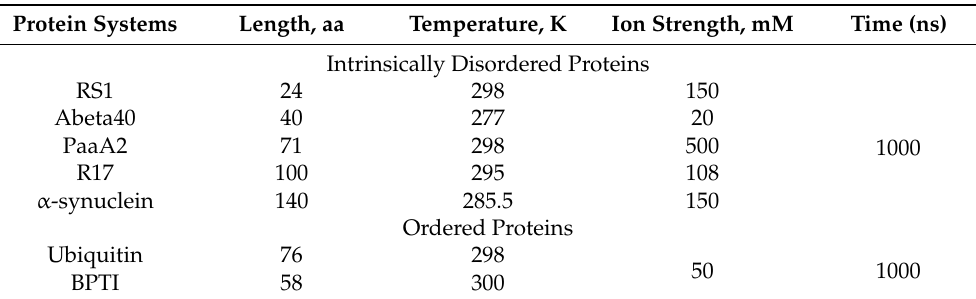
Table 2. Protein systems involved in this study. Molecular dynamic simulations are conducted according to the temperature and ion strength listed here. Protein